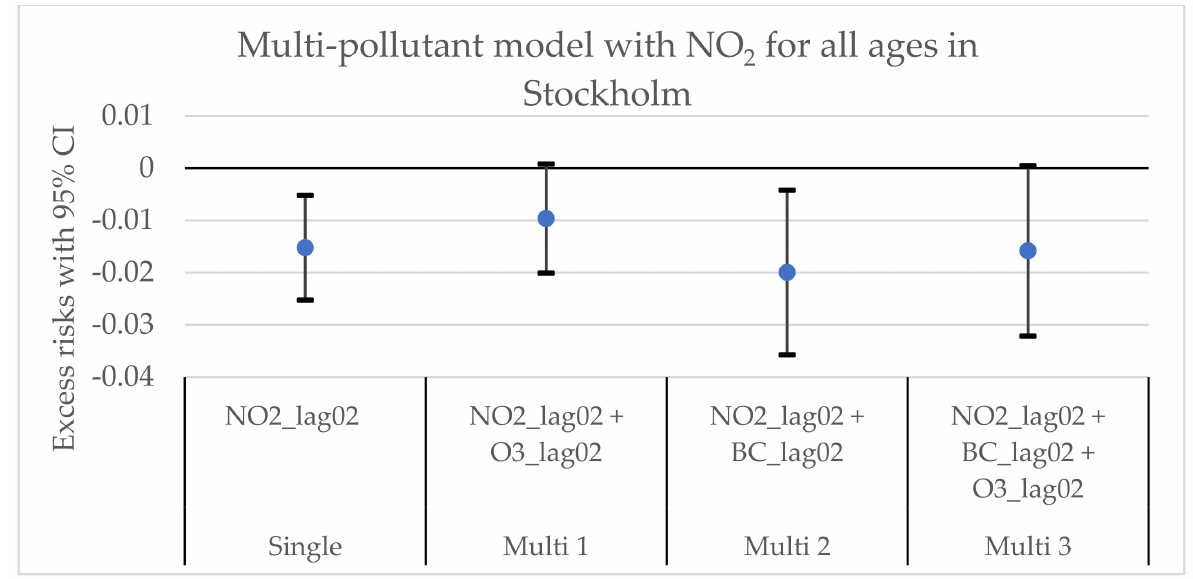
Figure A4. Multi-pollutant models of the estimated change in daily mortality in all ages (with 95% CI) for an IQR increase in the concentration of NO 2 (lag02) in Stockholm. From left to right: a single-pollutant estimate of NO 2 (Single), NO 2 adjusted for O 3 (Multi 1), NO 2 adjusted for BC (Multi 2), and NO 2 adjusted for both BC and O 3 (Multi 3).